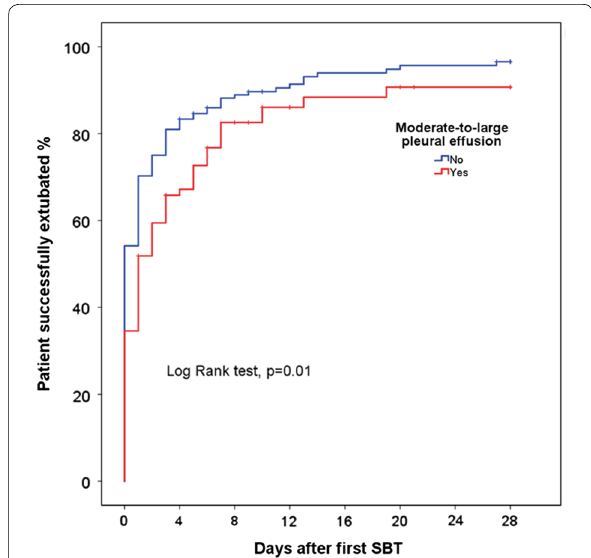
Fig. 2 Kaplan–Meier curves for the probability of successful extubation after the first spontaneous breathing trial in mechanically ventilated patients with (red lines) or without (blue lines) moderate‑to‑large pleural